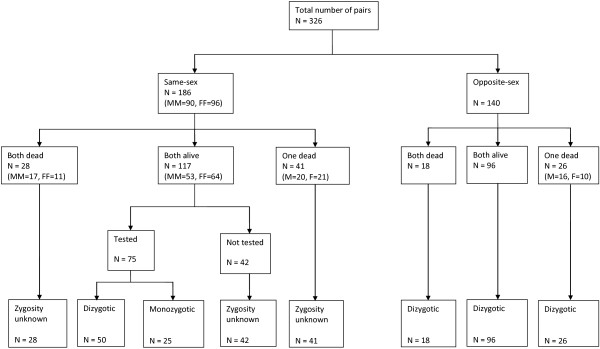
Zygosity sub-study. The flowchart includes 326 twin pairs (652 children) born at the hospital. Sex has been included in parenthesis (M = Male, F = Female).